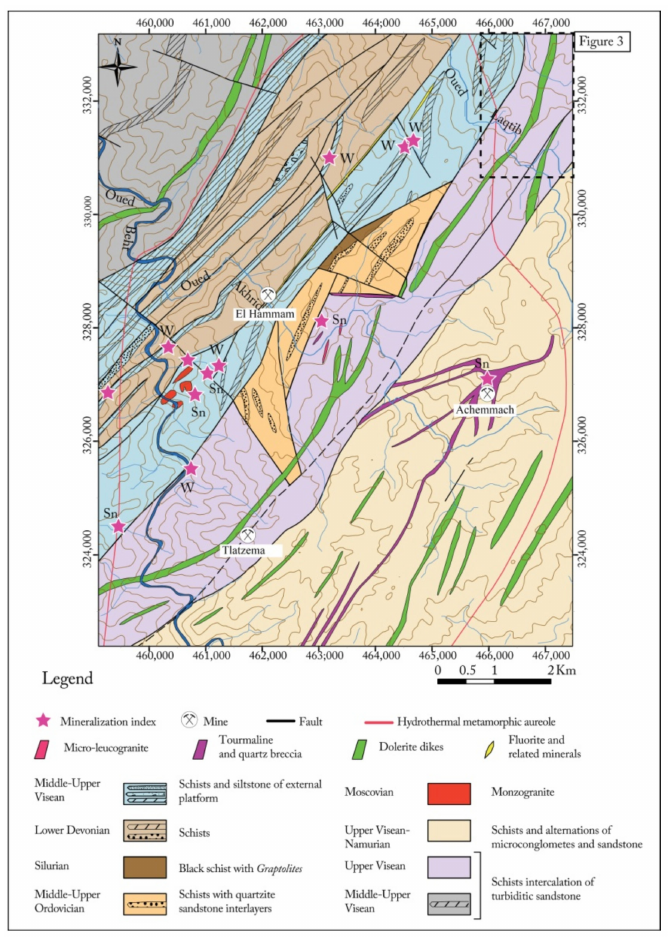
Figure 2. Geological map of the Achemmach-El Hammam district [6], Sn: Tin, W: